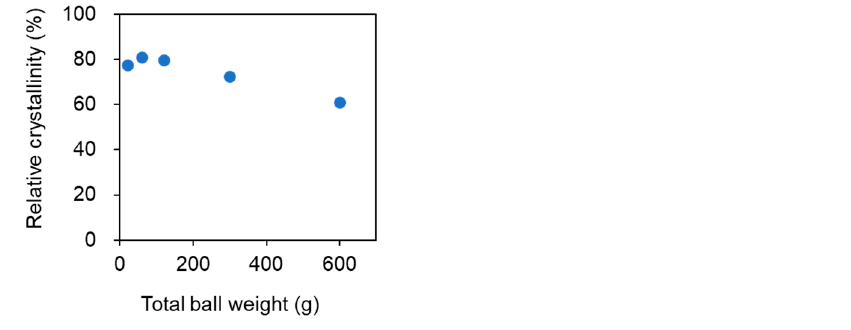
Figure 7. Dependence of relative crystallinity index of chitin nanofibers on total ball weight.